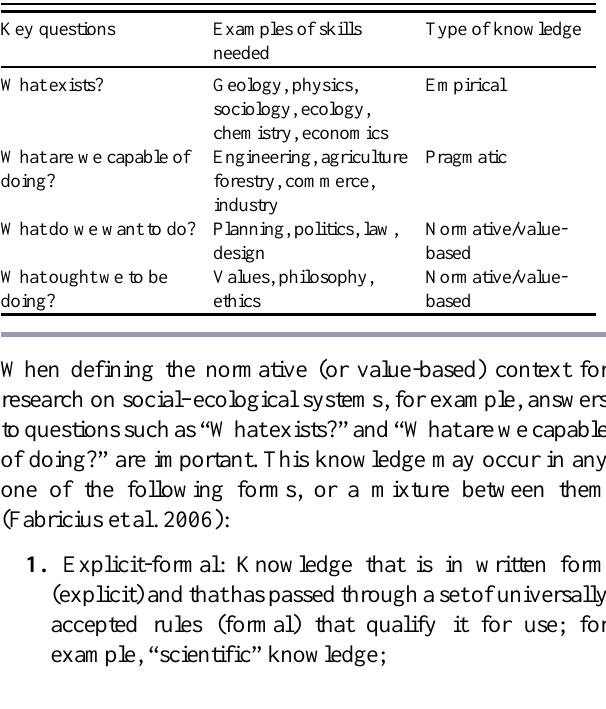
Table 1 . Skills and knowledge types included in transdisciplinary research (Max-Neef